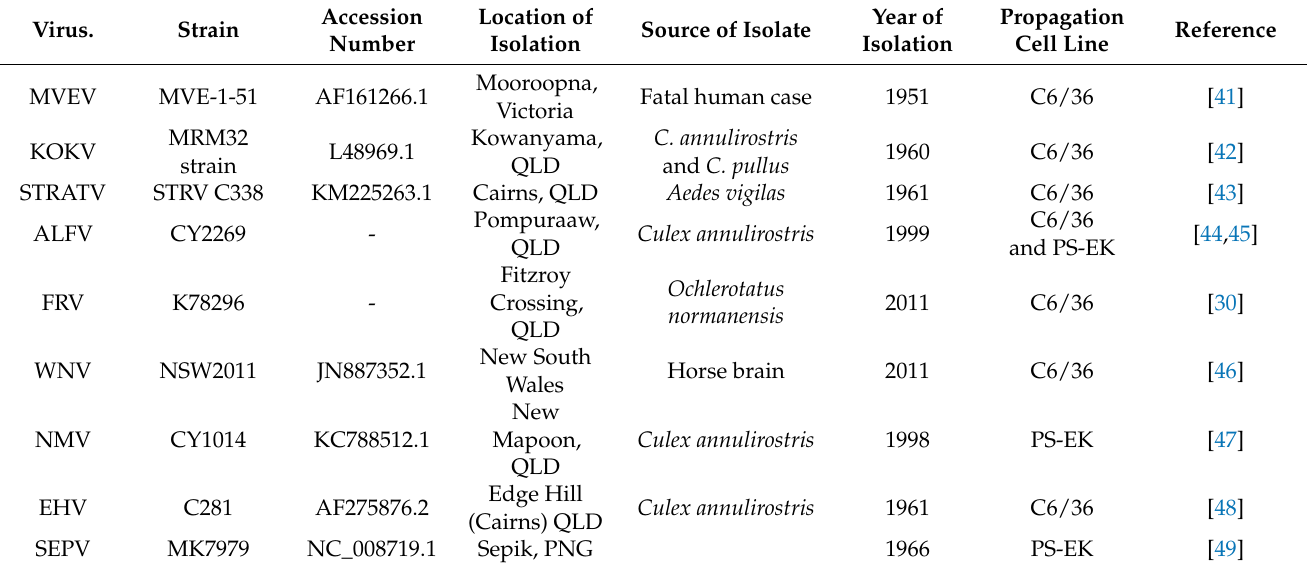
Table 1. Summary of viruses